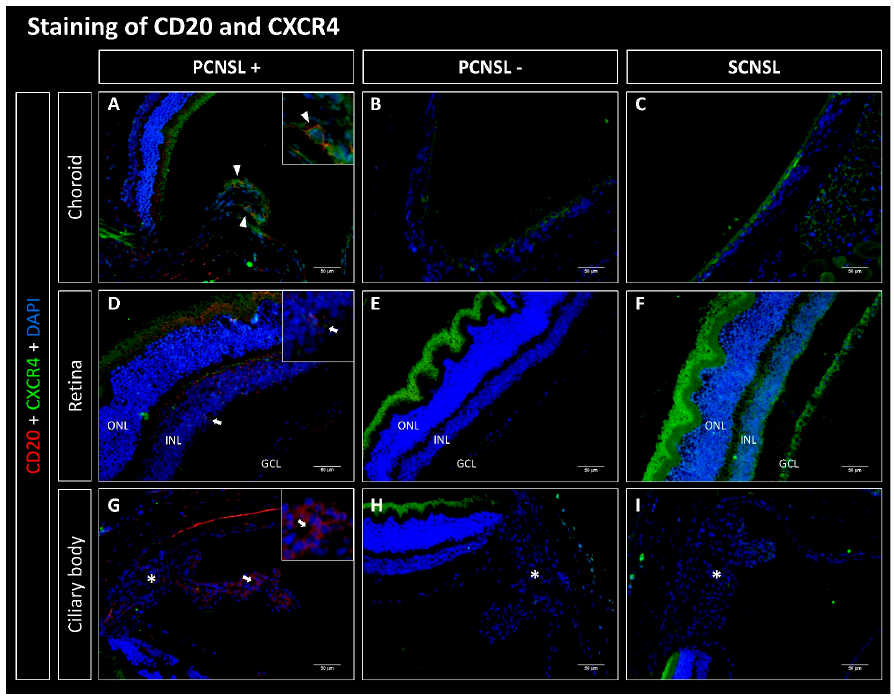
Figure 1. Fluorescence microscopy of CD20 (red) and CXCR4 (green) double staining of the eyes in the PDX PCNSL vs. PDX SCNSL group. ( A – C ) show recordings of the choroid, ( D – F ) of the retina and ( G – I ) of the ciliary body (marked with *). ( A ) shows the choroid infiltrated with CD20-positive primary CNS lymphoma cells (PCNSL+), which additionally express CXCR4 (triangles). ( D , G ) show retina and ciliary body infiltrated with CD20-positive cells (PCNSL+) without co-expression. Neither CD20- nor CXCR4-positive cells were found in the PCNSL negative (PCNSL-) group ( B , E , H ) and in the SCNSL group ( C , F , I ). ONL = outer nuclear layer, INL = inner nuclear layer, GCL = ganglion cell layer; scale bar 50 µ